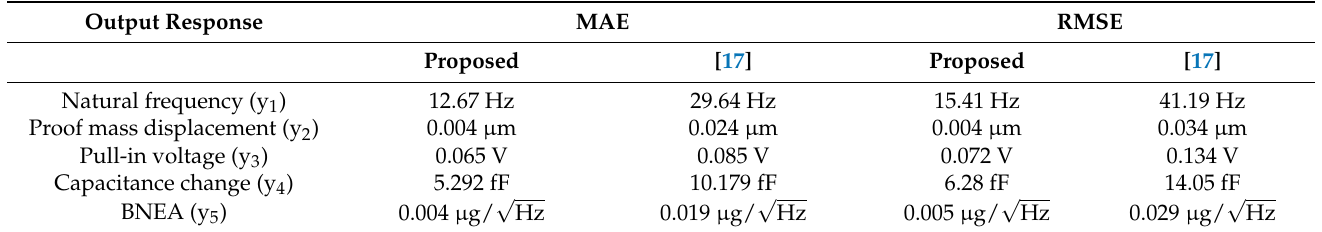
Table 2. Comparison of the predicted output responses (y 1 , y 2 , . . . , y 5 ) obtained using the proposed